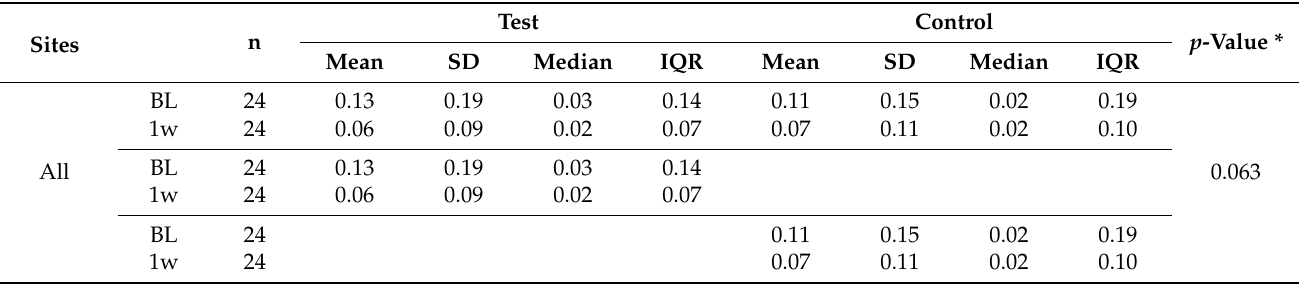
Table 4. Gingival index analysis with the repeated measures Friedman